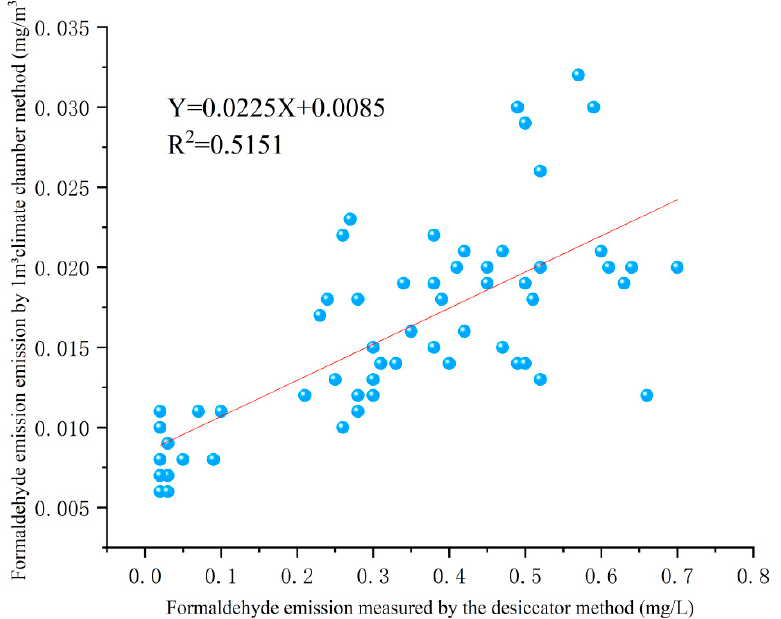
Figure 4. The relationship of formaldehyde emissions between the desiccator method and the climate chamber .